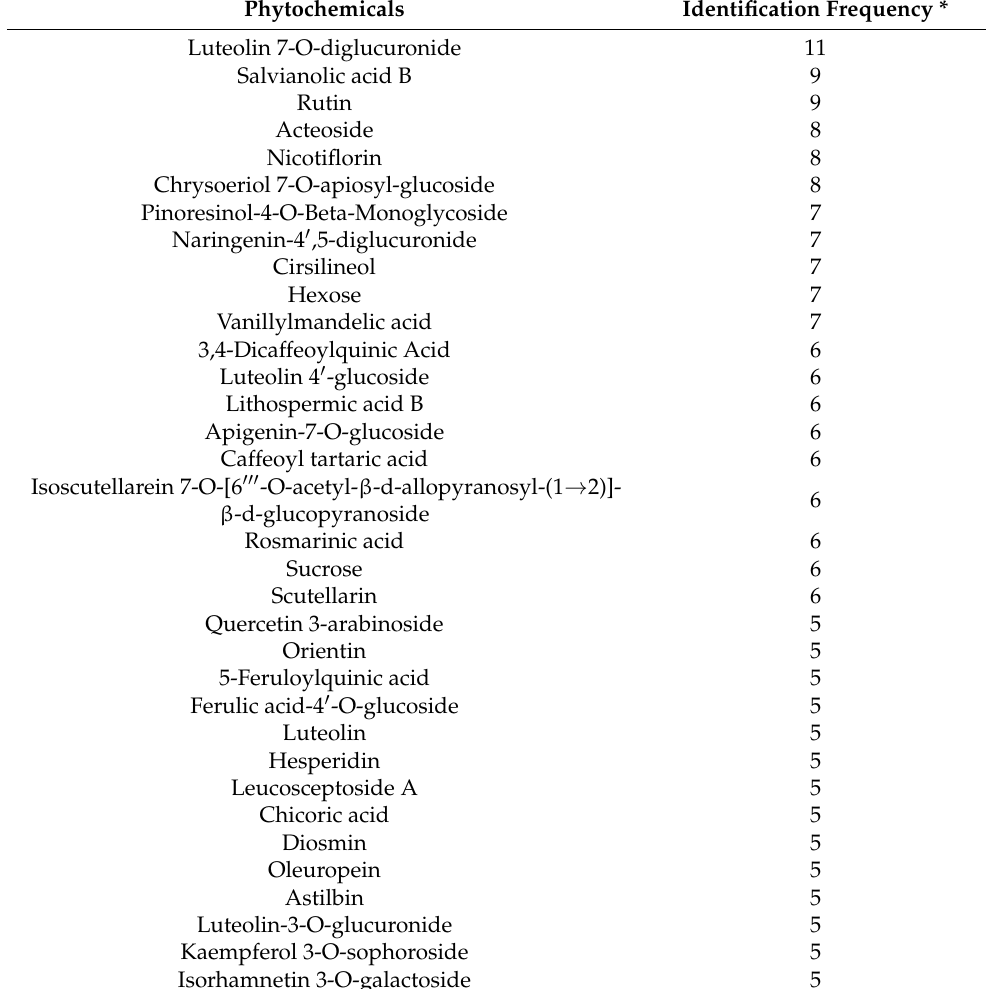
Table 3. Common phytochemicals identified among the studied extracts and their respective identifi- cation